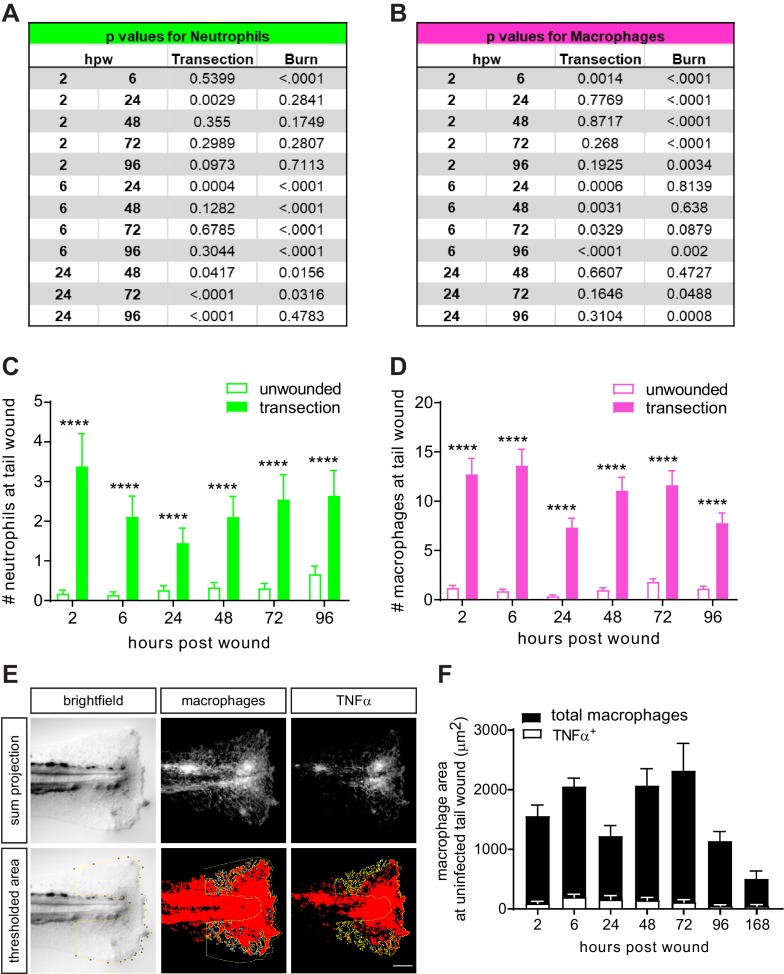
Leukocyte recruitment in the caudal fin tissue is minimal in unwounded larvae.Additional p values associated with Figure 2B and C are provided for (A) neutrophils and (B) macrophages to reflect changes over time within each injury. Leukocyte recruitment in unwounded larvae or following simple transection was quantified using double transgenic larvae (Tg(lysC:mCherry-histone2b) x Tg(mpeg1:GFP-histone2b)). (C) Neutrophils and (D) macrophages were counted in caudal fin area distal to the caudal vein loop in single-plane images acquired by Zeiss Zoomscope. Values are least square means and SE from three biological replicates, with associated p values. Total N = 29–34 larvae per time point for each treatment. ****<0.0001. (E) Example of quantitation by area thresholding (see Materials and methods). (F) For clarity, values for uninfected transection from Figure 2G were plotted alone to show full data range.